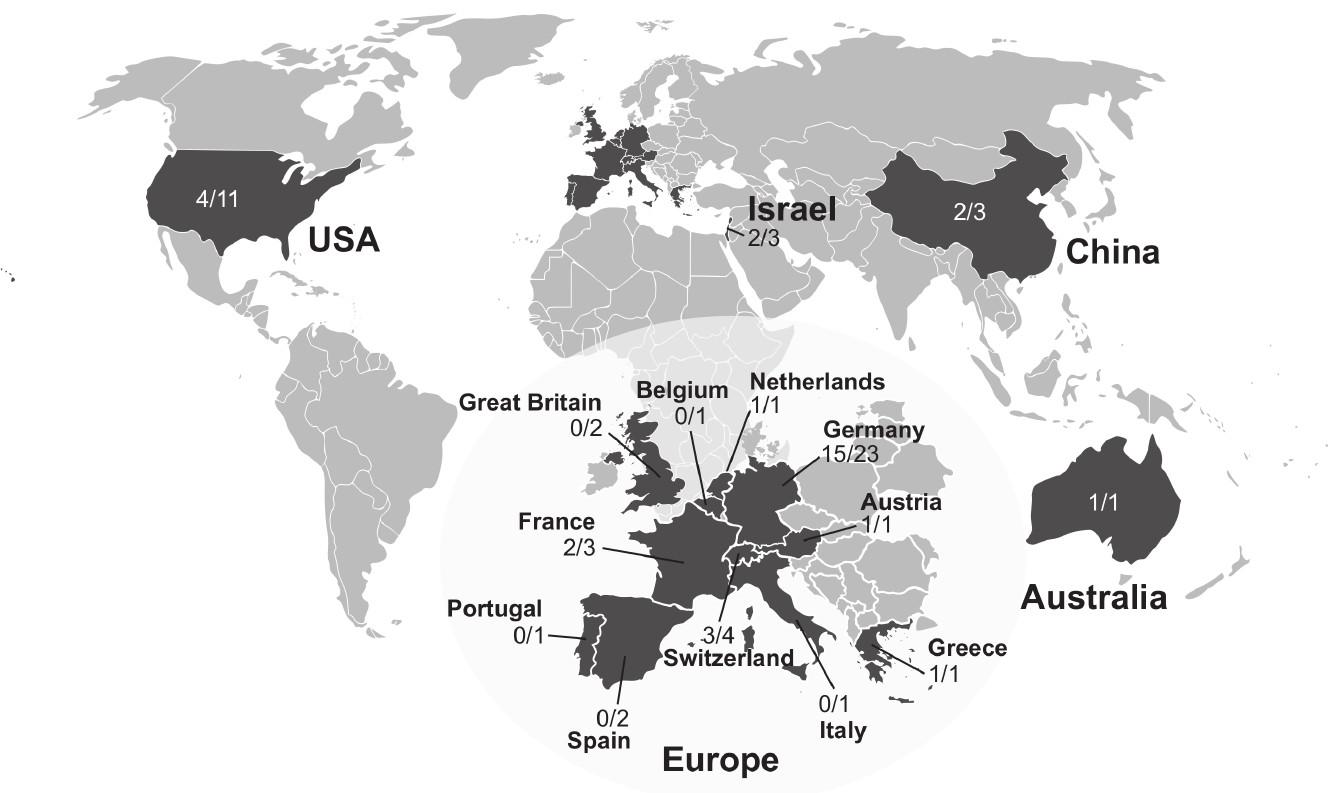
Fig 5. MuAstV positive institutes worldwide based on serology data of imported animals to the DKFZ from 2015 until March 2017. Mice from a total of 58 institutes in 15 different countrieswere tested by multiplexMuAstV serology(S5 Dataset). The numberof research institutes that sent sero- positive mice dividedby the total number of institutes tested is presentedfor each country. Creative CommonsBlankMap-World gray by Vardion2006 (https://commons.wikimedia.org/wiki/File:BlankMap-World_gray.svg) licensedunder CC BY-SA 3.0 was used as map basis and modified by the authors.